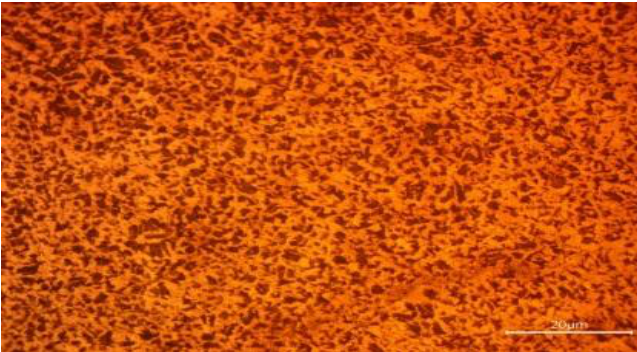
Fig. 5. Microstructural of as received sample.